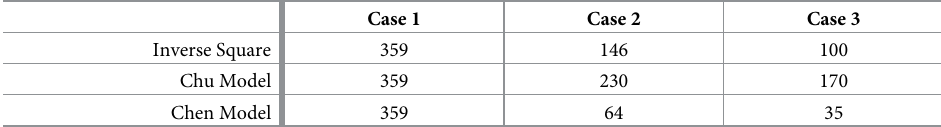
Table 1. Relative risks with different decay assumptions for a three-hour